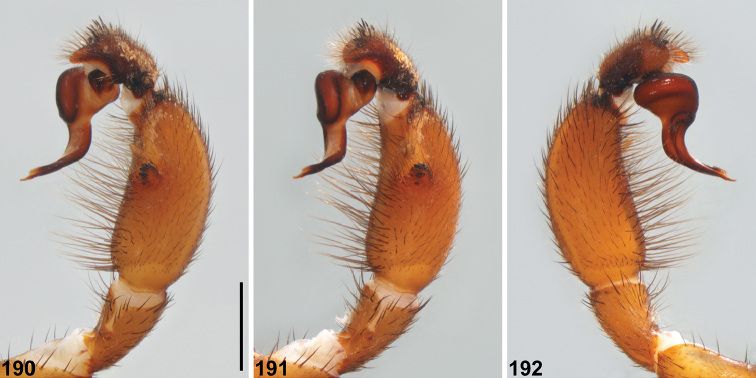

Idiosoma
gutharuka sp. n., male holotype (WAM T38517) from Gutha (Western Australia; AVW), pedipalp. 190 Retrolateral view 191 Retroventral view 192 Prolateral view. Scale bar 2.0.